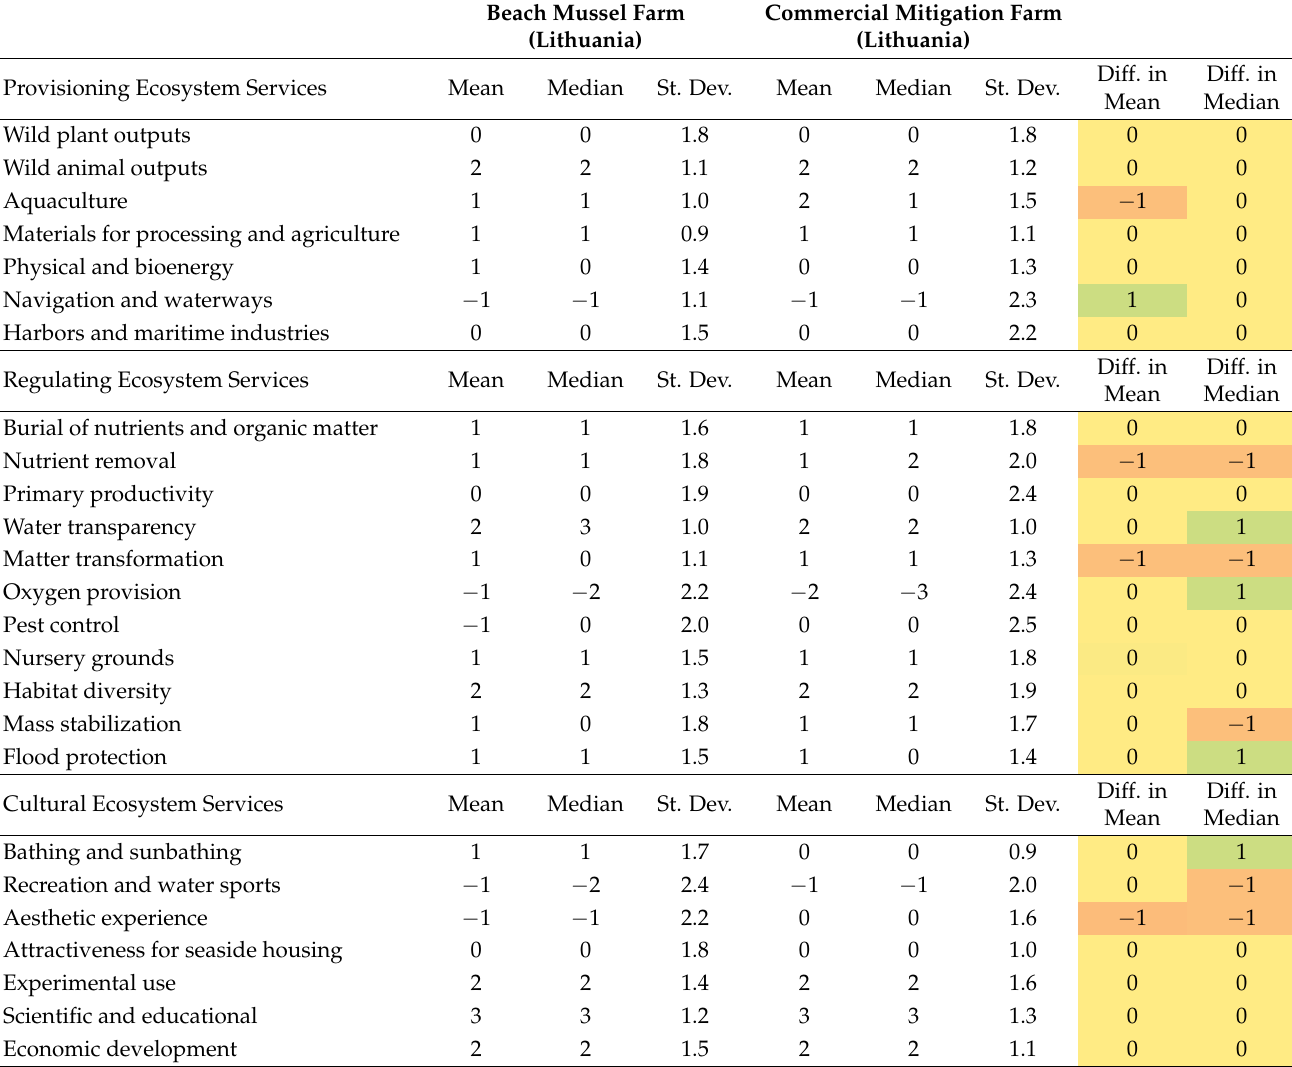
Table 7. Comparison of two mussel farm applications assessing the impacts on ecosystem services. The mussel farm applications are a beach mussel farm and large-scale commercial mitigation mussel farm both located in the Curonian Lagoon. The assessment was conducted by experts. The mean and median values were calculated based on the aggregated number of